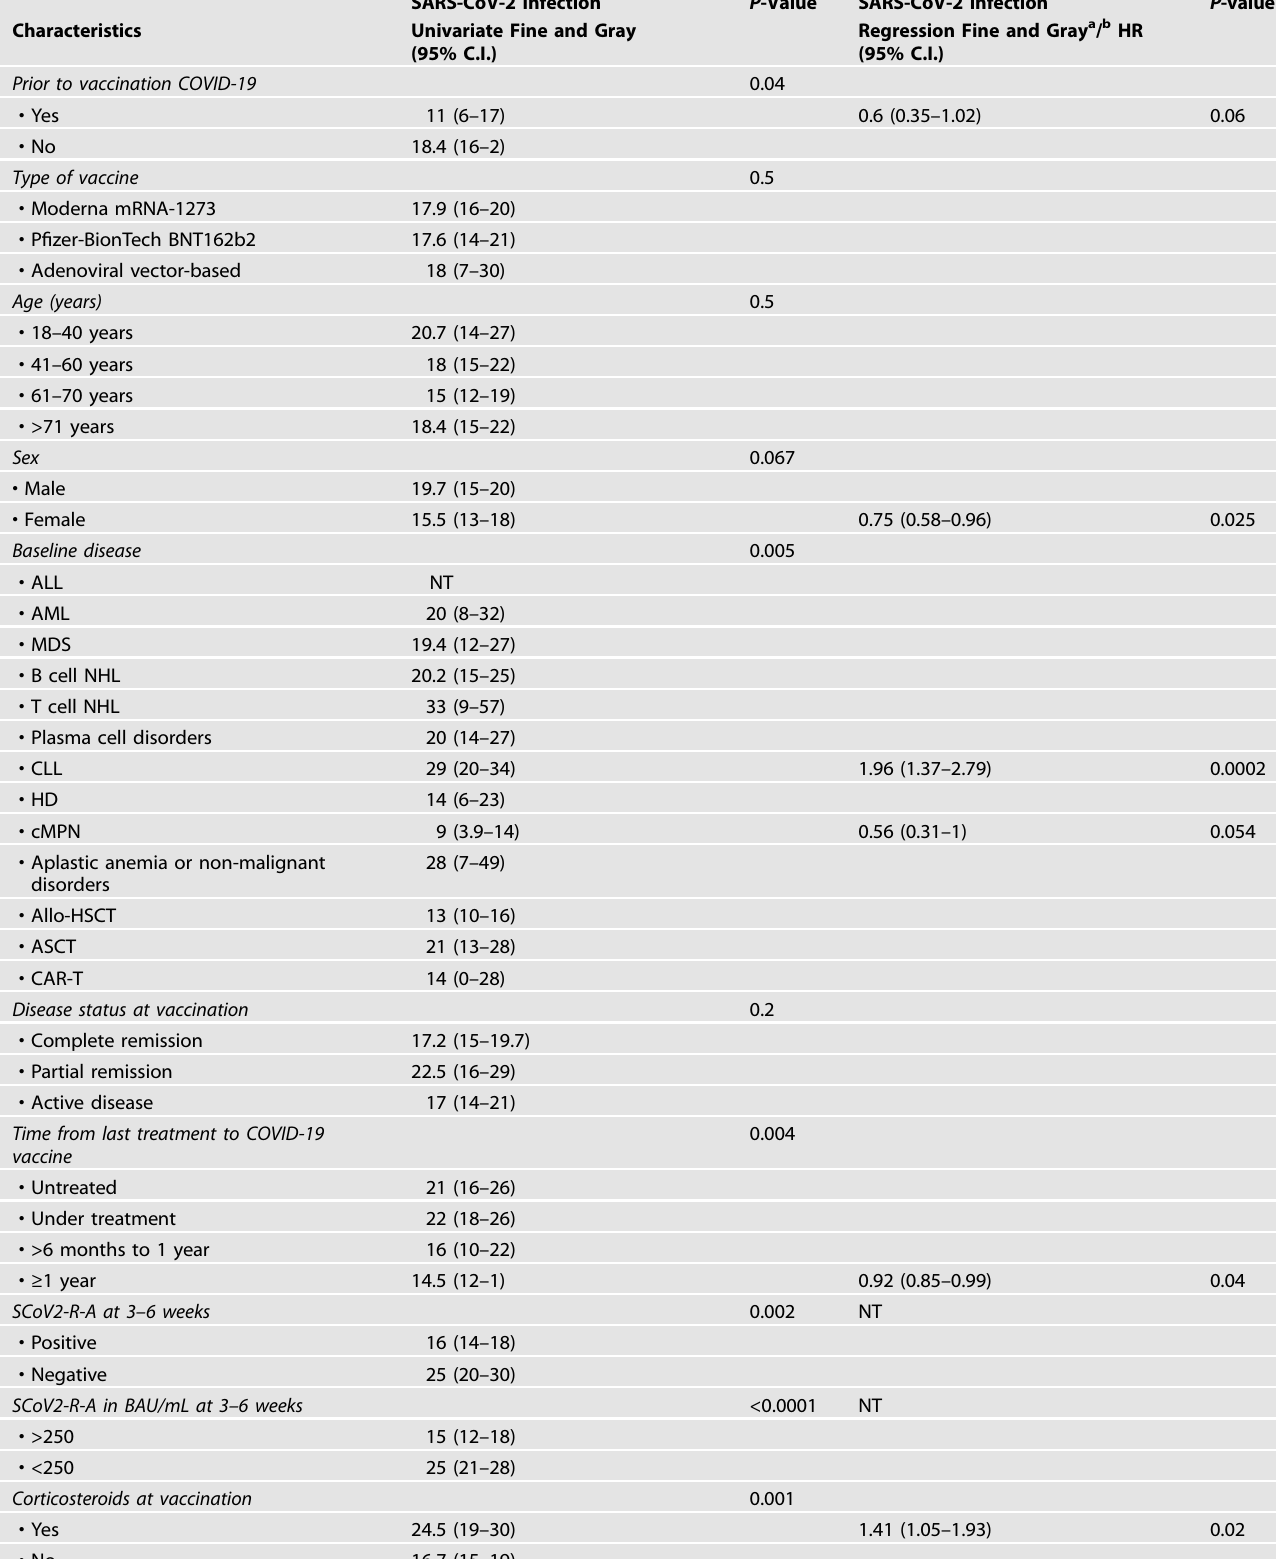
Table 3. Logistic regression univariate and multivariate analyses of factors predicting SARS-CoV-2 breakthrough infection after full vaccination. SARS-CoV-2 infection P -Value SARS-CoV-2 infection